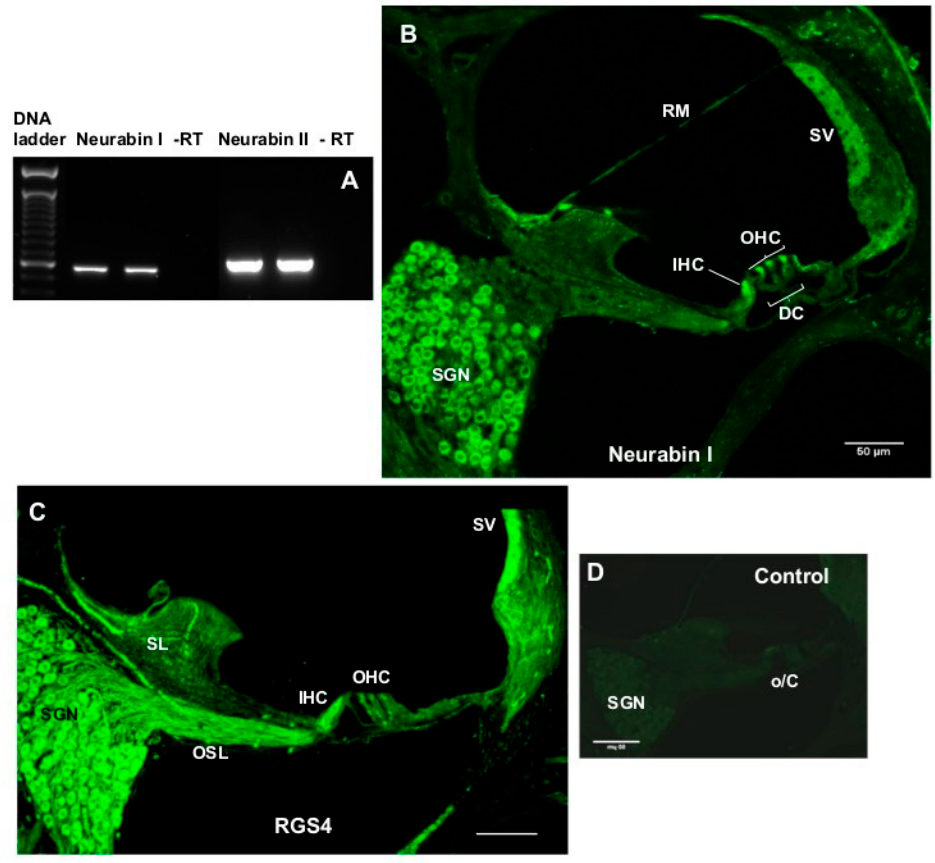
Table 1. Primer sequences and positions for neurabin I and II isoforms .